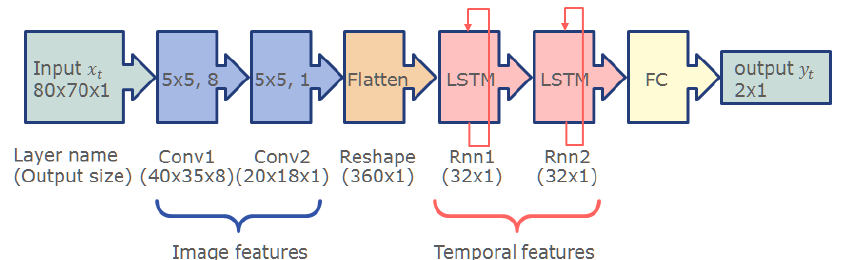
Figure 6. Network to detect bubbles in the optical path. The convolutional layers extract image features, such as bright and dark edges, bright spots, etc., while the LSTM layers account for the temporal components. The network is able to detect bubbles traversing in both directions and even accounts for those that remain static in the optical path for an extended